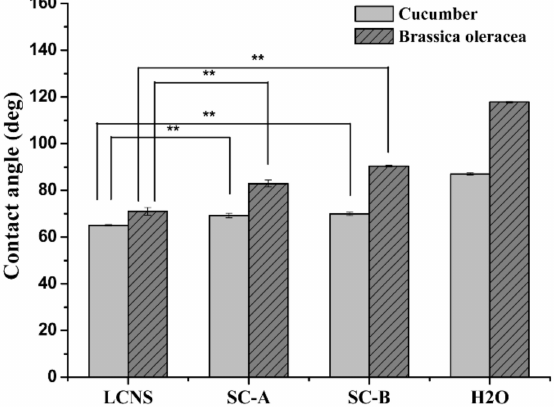
Figure 5. Contact angles of different lambda-cyhalothrin formulations on cucumber and brassica oleracea leaves (one-way ANOVA, followed by LSD test, ** p <